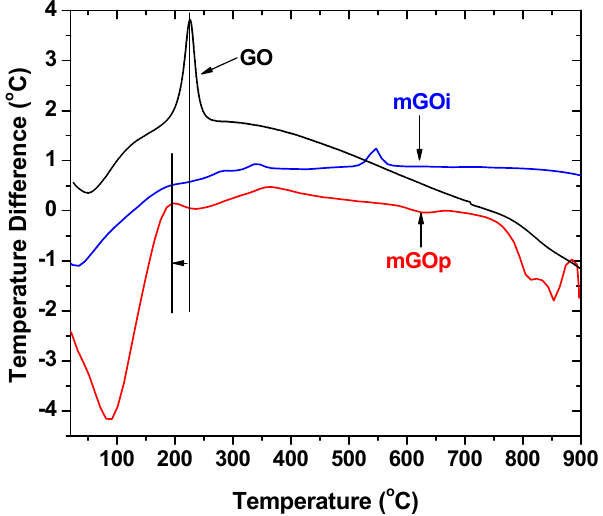
Figure 5. Differential thermal analysis (DTA) curves in